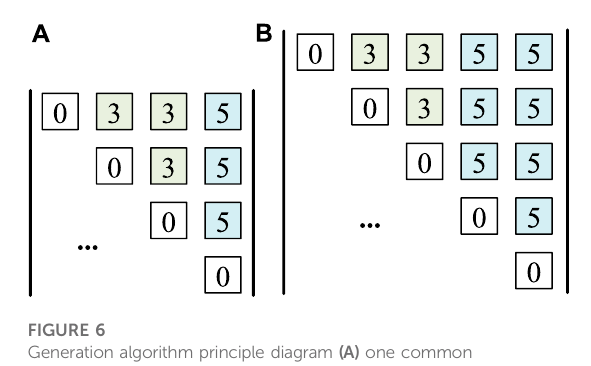
FIGURE 6 Generation algorithm principle diagram (A) one common connectionpointsituation (B)